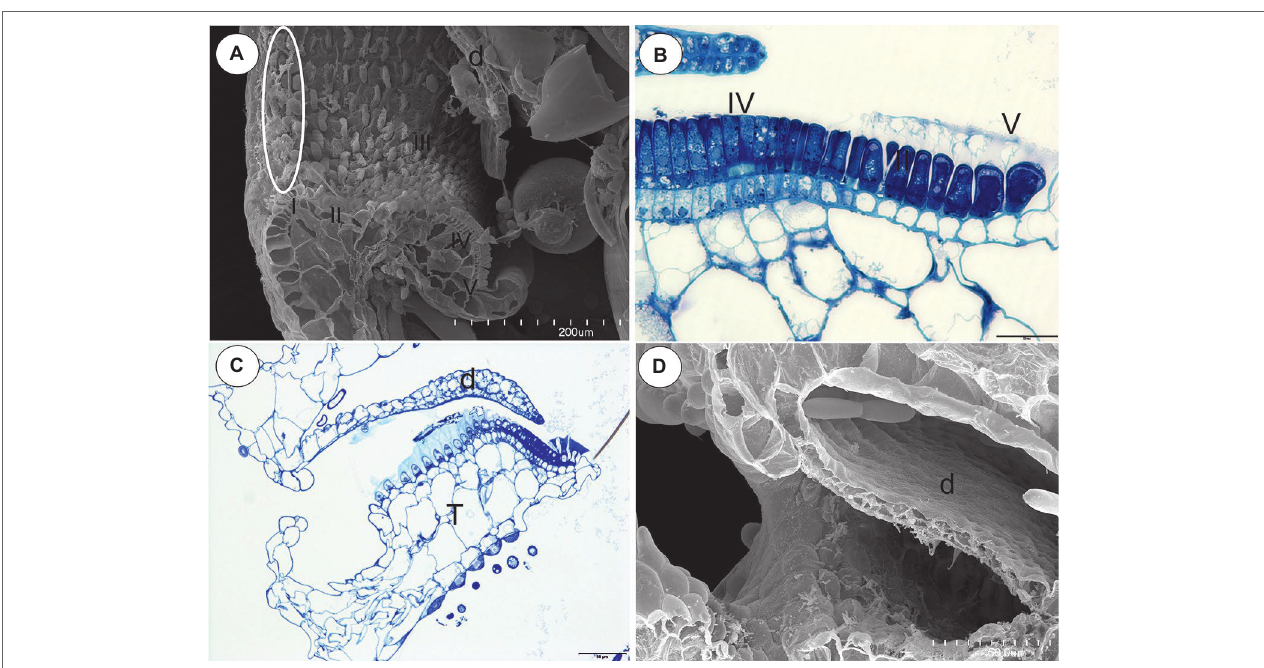
FIGURE 3 | The structure of the pavement epithelium of the Utricularia species; sections Pleiochasia and Lasiocaules . (A) A longitudinal section of a Utricularia tubulata trap entrance, note the outer velum (white ellipse) and the zones of the pavement epithelium, door (d); scale bar = 200 μ m. (B) U. volubilis A semi-thin longitudinal section of part of the threshold showing zone 4 (IV) and zone 5 with mucilage trichomes (V); scale bar = 20 μ m. (C) A longitudinal section of a Utricularia uniflora trap entrance, threshold (T), door (d); scale bar = 50 μ m. (D) SEM image of a longitudinal section of a Utricularia uniflora trap entrance, note the lack of an outer velum, door (d); scale bar = 50 μ